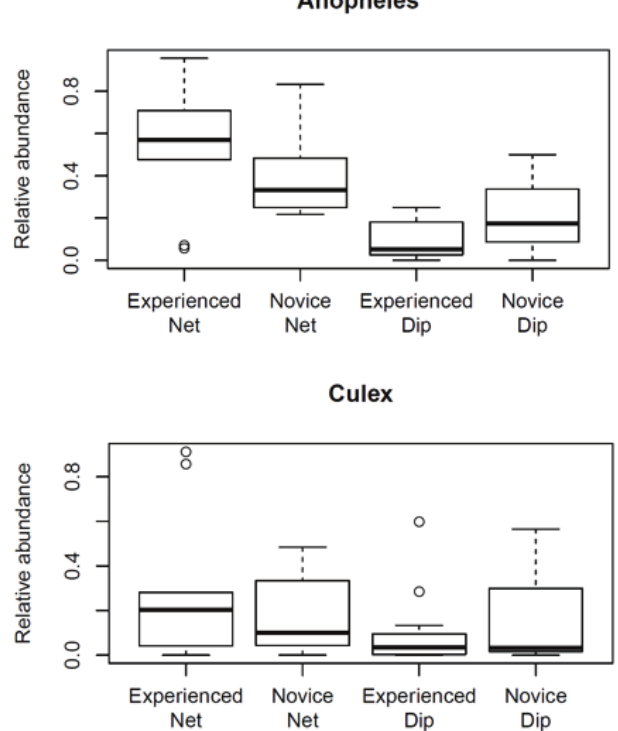
Figure 2. Box plot representations of relative proportions of mosquito specimens grouped by genus captured using the larval sweep net and larval dip by collectors of different experience levels.